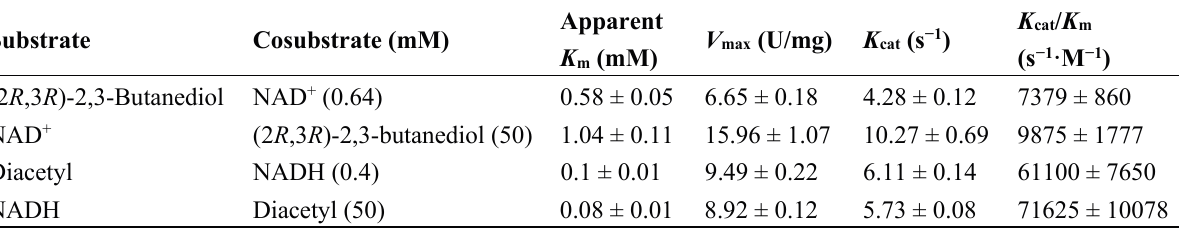
Table 4. Kinetic parameters of